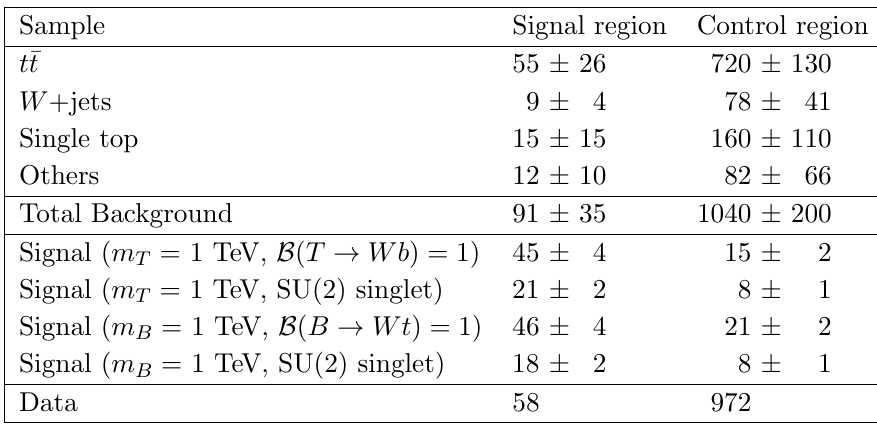
Table 1 . Event yields for background sources and several signal models in the signal and control regions. The yields are given before the pro(cid:12)le likelihood (cid:12)t described in section 7. The quoted uncertainties include statistical and systematic uncertainties; for the t (cid:22) t background no cross-section uncertainty is included. The contributions from dibosons, Z +jets, ttV and multi-jet production are included in the Others